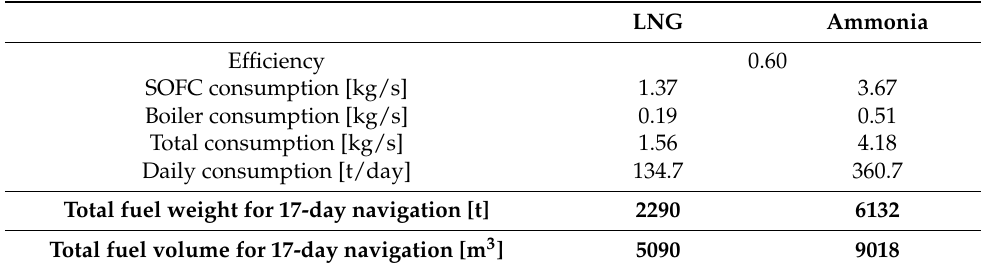
Table 10. Consumption calculations for LNG- or ammonia-fueled